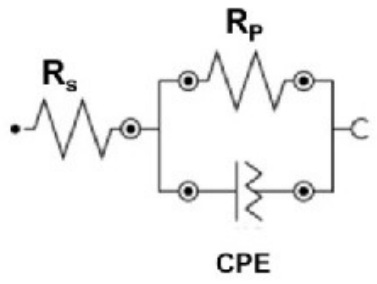
Figure 4. Equivalent circuit used for impedance data